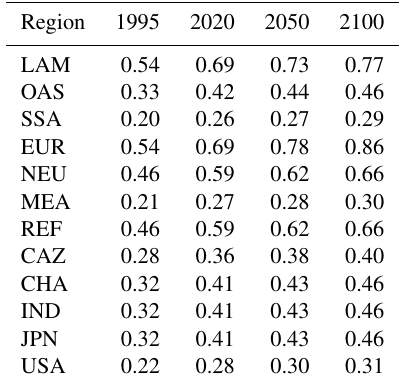
Table A4. Percentage of production that can possibly come from plantations based on Pöyry (1999).